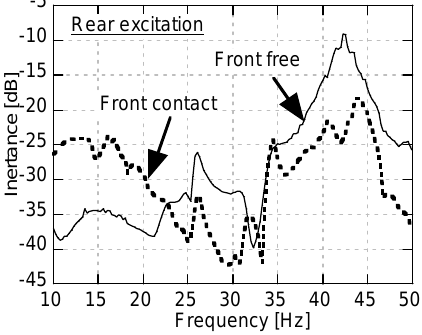
Fig. 4. Inertance of measurement point P on the handlebars, longitudinal direction ( x ) .